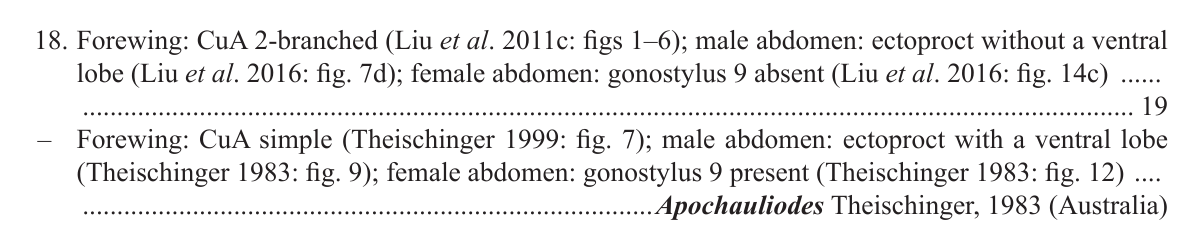
abdomen: gonapophysis 8 narrow, subtriangular